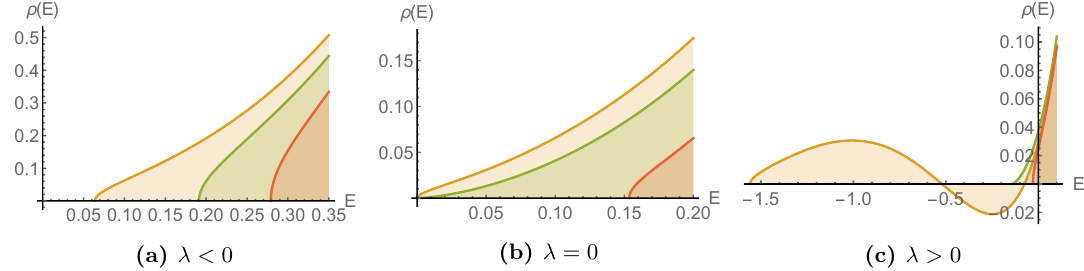
, green is critical K = K = cr ; (c) yellow is K > K > cr